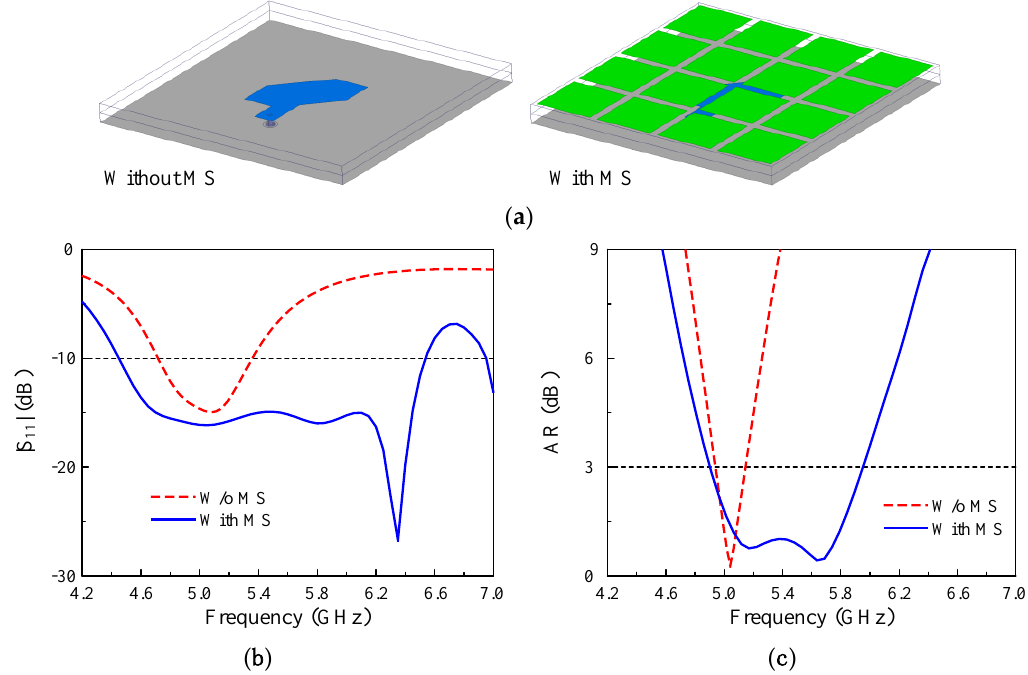
Figure 3. ( a ) Geometry and simulated ( b ) |S 11 | and ( c ) axial ratio (AR) of the antenna with and without a uniform MS. The optimized dimensions for the antenna with MS are as follows: W s = 40, H s = 1.52, W p = 12, d = 6.8, L f = 8.5, W f = 3, p = 10, W i = W o = 8.8 (unit: mm).